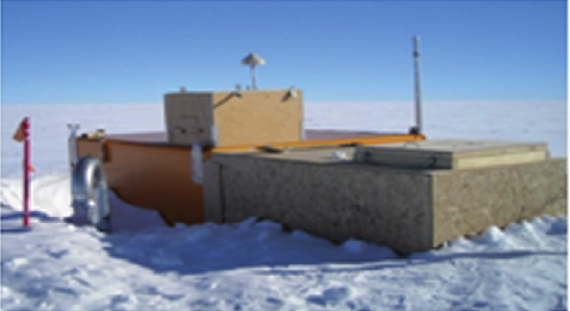
Figure 4. The ISACCO-DMC1 station installation site (latitude, 75.106°S; longitude, 123.305°E; 3270 m